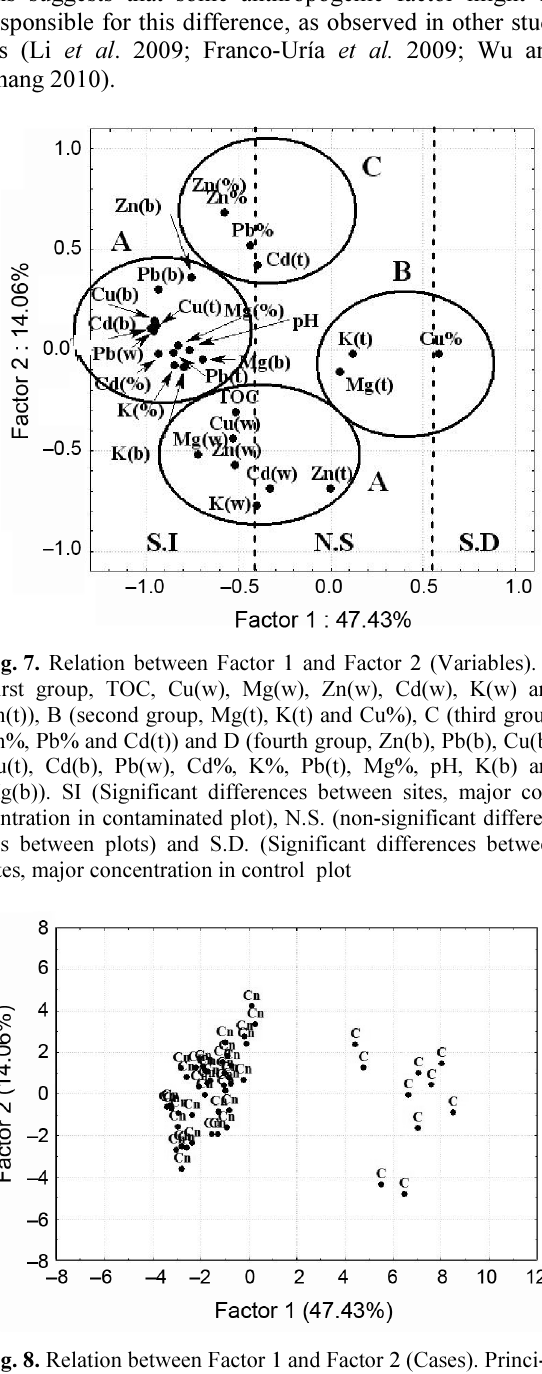
Fig. 8. Relation between Factor 1 and Factor 2 (Cases). Princi- pal component plot of all the samples collected on contaminated (Cn) and control (C)